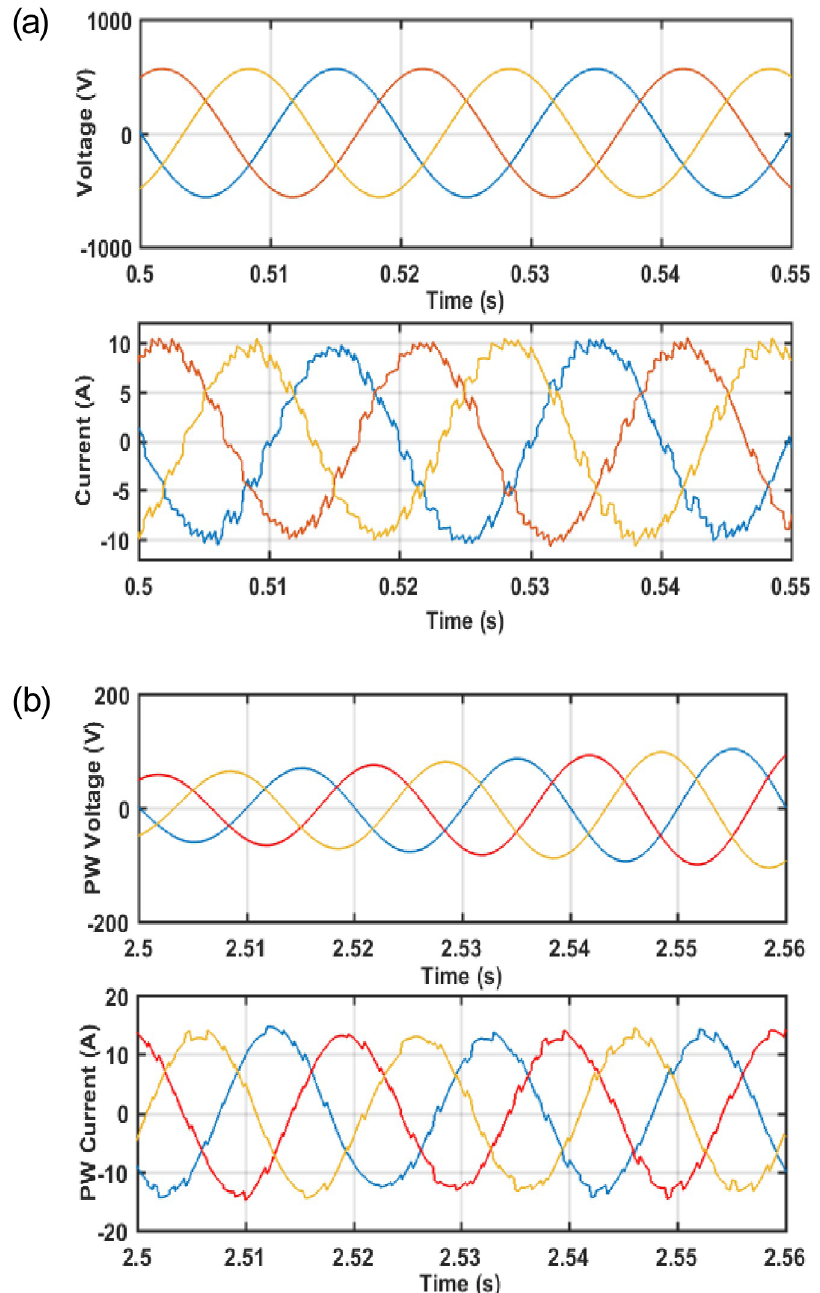
Fig 10. (a) During normal condition (b) During a fault